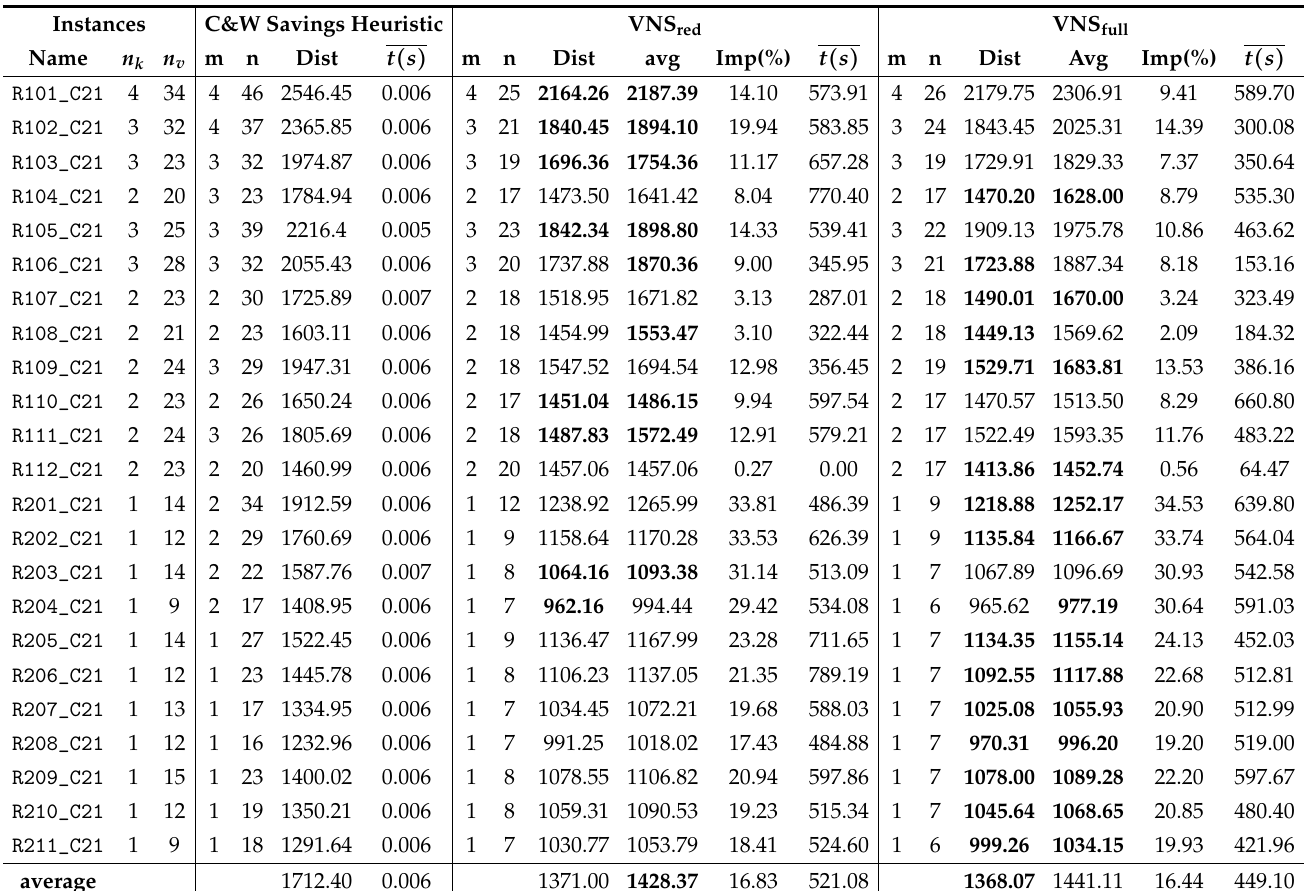
Table 9. Computational results for large-sized random instances.